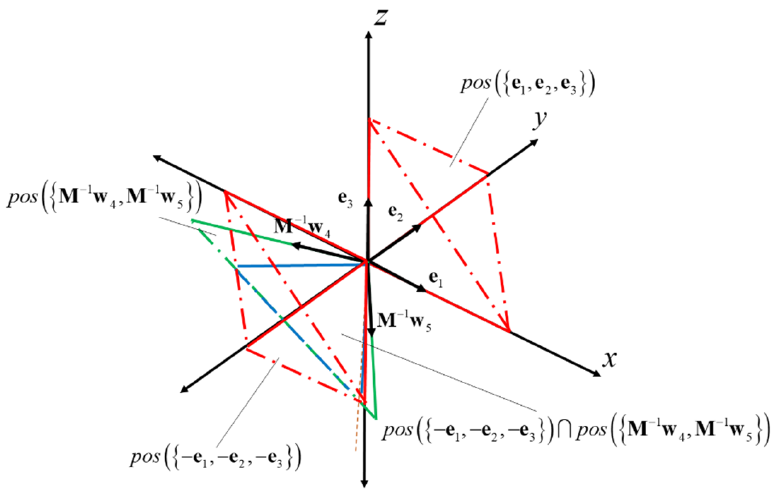
Figure 5. Specific case of a certain 2-redundant actuators-planar CDPM when general coordinate of moving platform presented in the wrench-closure workspace and linear equivalence is applied.